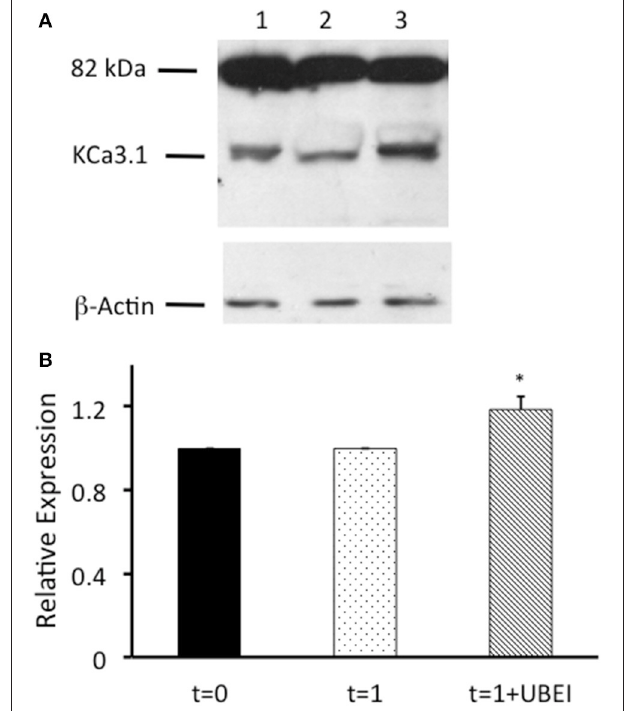
FIGURE 4 | Effects of UBEI-41 on surface streptavidin labeled KCa3.1-BLAP channels. (A) Cells were incubated for 1 h with F12 media, or F12 media with 50 µ M UBEI-41, then labeled basolaterally with streptavidin, followed by lysing and detection of KCa3.1 by immunoblot. Lane 1. KCa3.1 non-treated control cells. Lane 2: KCa3.1 1 h incubation, non-treated. Lane 3: KCa3.1 with 1 h incubation of UBEI-41. Each lane was loaded with 30 µ g of protein and β -actin was used as a loading control. (B) Immunoblot results were quantified by densitometry. Protein expression of each time point was referenced to the control non-treated cells. Densitometry data showed that with the application of UBEI-41, the surface expression of KCa3.1 rose by 20% with 1 h treatment of UBEI-41 (hatched bar). *1 h UBEI-41 treated cells exhibited a statistically significant increase in expression of KCa3.1 than the non-treated cells (dotted bar; P ≤ 0.05, n =